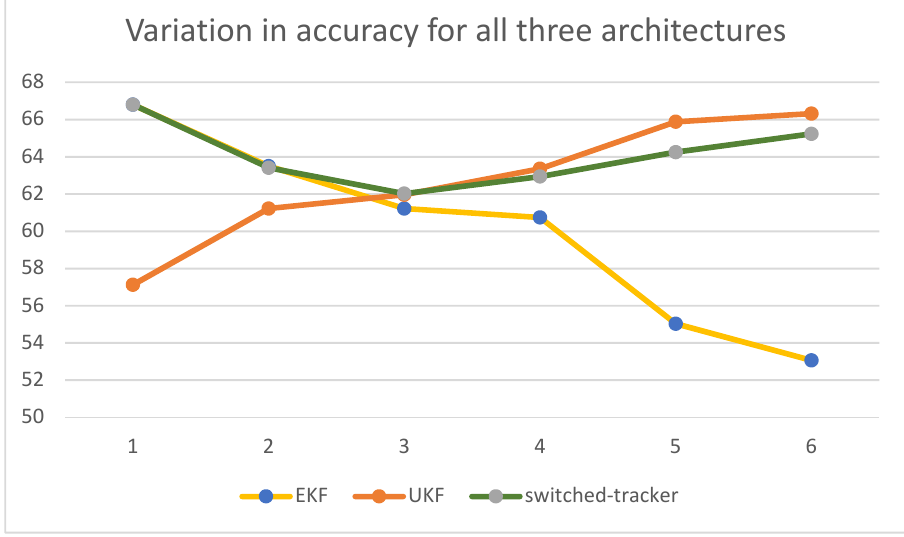
Figure 21. Variation in accuracy of the three architectures. The video number is represented on X -axis (traffic density increases as video index number increases) and average OR value is represented on the y -axis.